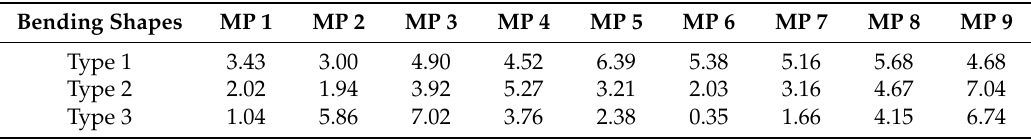
Table 7. The relative error percentages of the displacements at each measuring point (MP) after classification